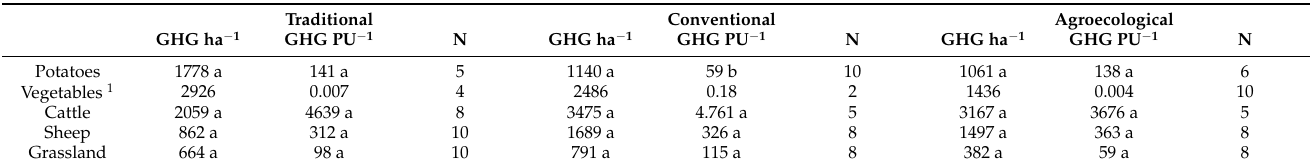
Figure 4. Total farm annual GHG emissions per hectare in the different existing agricultural systems on Chiloé Island. The black line indicates the median and the yellow line the mean; the black circles represent the 10 farms in each system. Table 3. Median GHG emission (kg CO 2 -eq ha − 1 year − 1 ) of the existing agricultural systems on Chiloé Island.